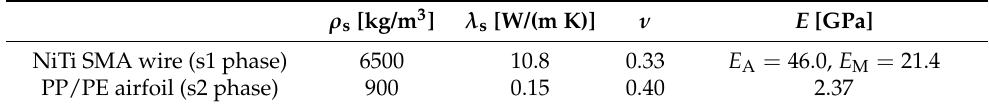
Table 1. Solid-phase